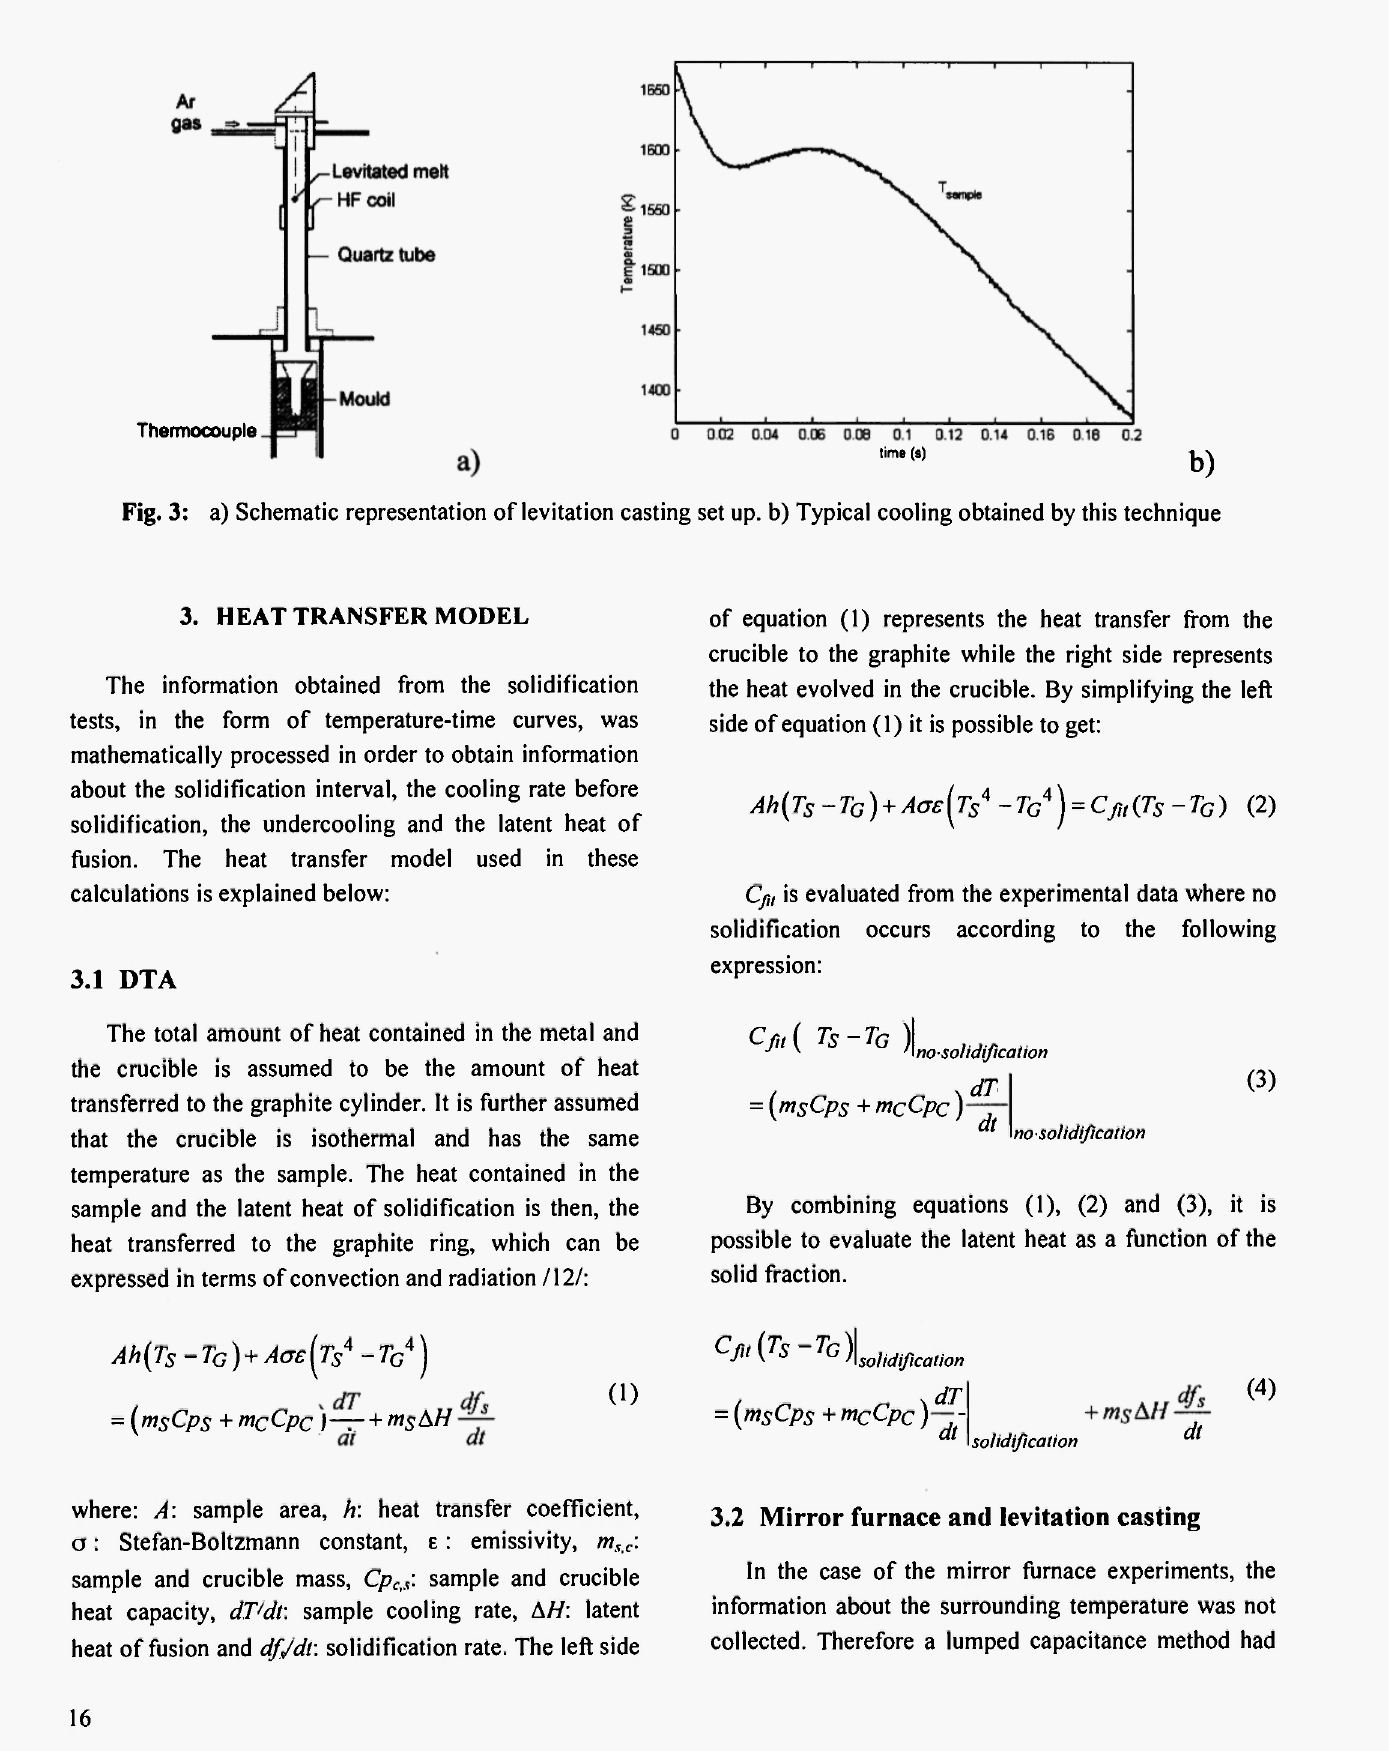
lime (s) ^ casting set up. b) Typical cooling obtained by this